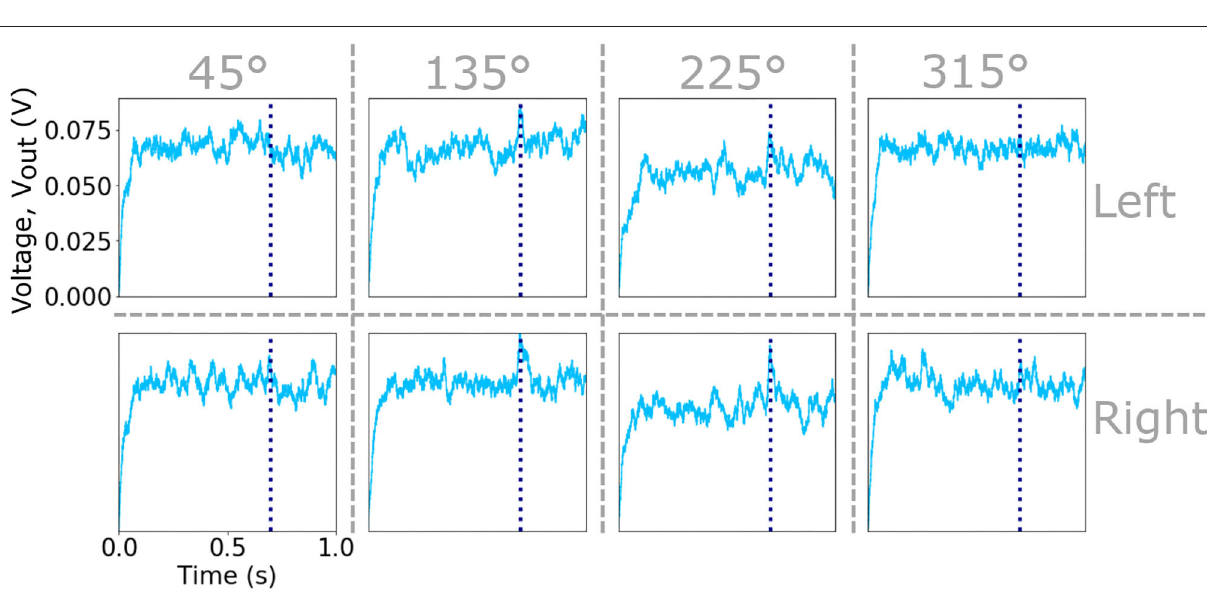
from the input layer neurons encoding air currents coming from behind due to slow and fast stimuli (originating from long and short receptor sub-populations on the cerci,